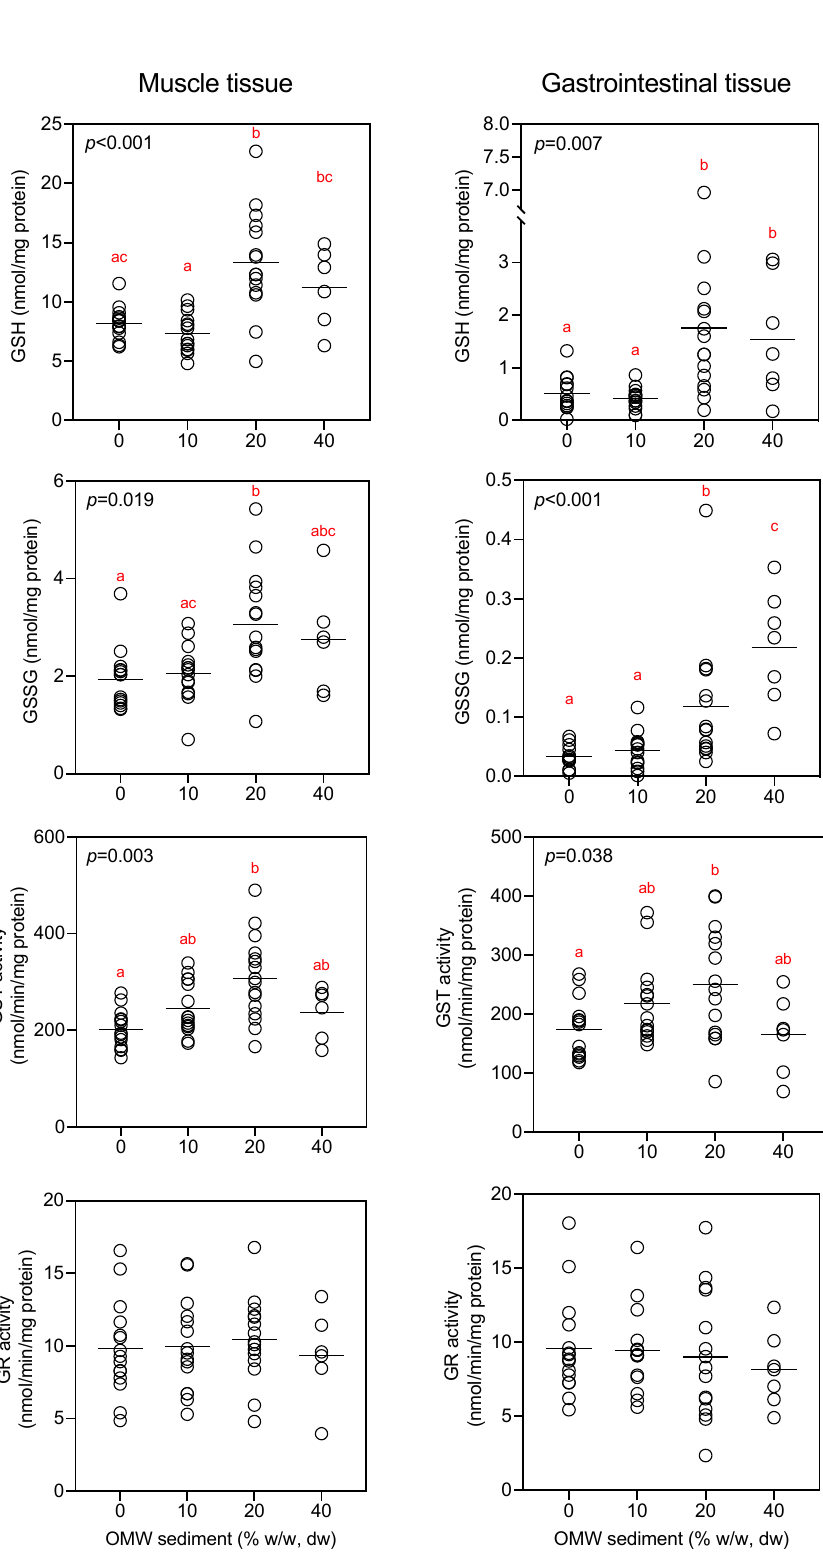
Figure 3. Response of glutathione-dependent antioxidant mechanisms in the body wall muscle and gastrointestinal tract of earthworms after 30 d of exposure to olive mill waste (OMW)-amended soils. Horizontal solid lines in the univariate scatterplots are the mean values. Different letters denote statistical differences ( p < 0.05, Games–Howell post-hoc test). GSH = reduced glutathione, GSSG = oxidized glutathione, GST = glutathione S -transferase, GR = glutathione reductase. The IBRv2 index was used to assess the biomarker responses. The index clearly showed that the highest OMW concentration induced oxidative stress in earthworms, as evidenced by the high A i